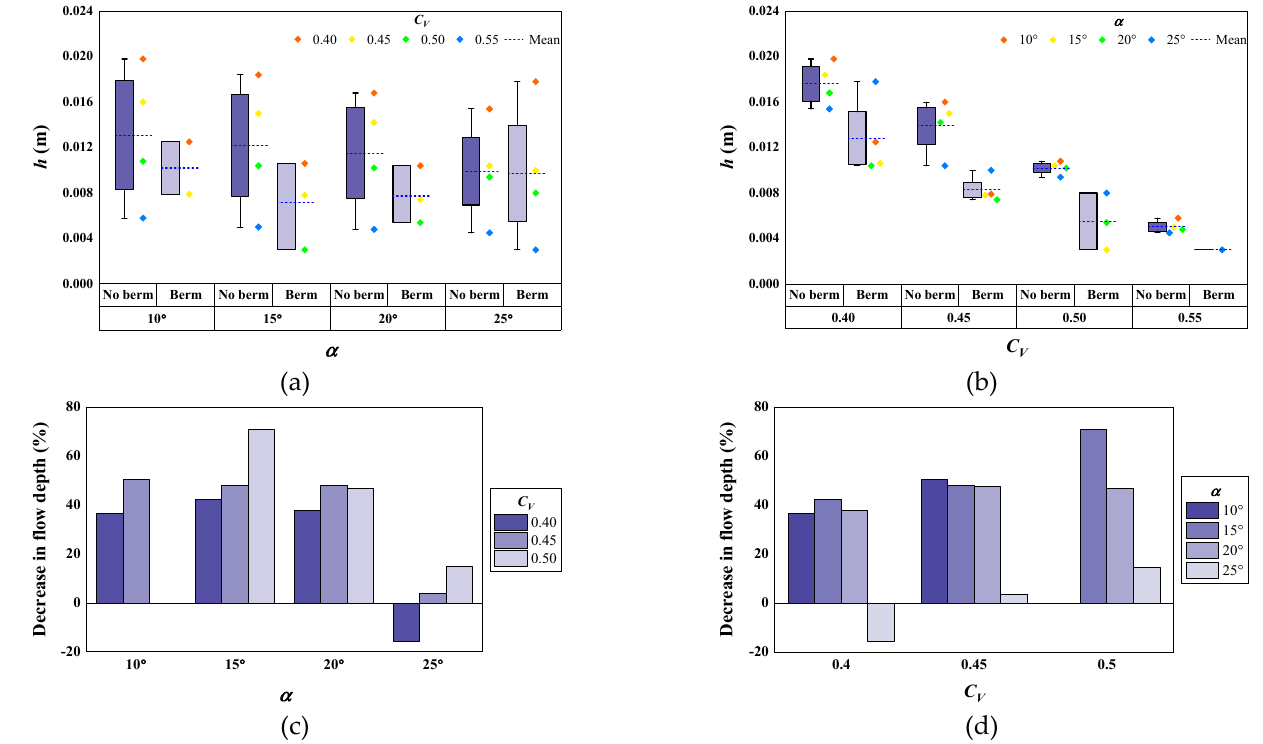
Figure 7. ( a ) Flow depth according to α (at C V = 0.40–0.55); ( b ) flow depth according to C V (at α = 10°–25°); ( c ) percent decrease in flow depth due to berm according to α (at C V = 0.40–0.50); ( d ) percent decrease in flow depth due to berm according to C V (at α = 10°–25°).